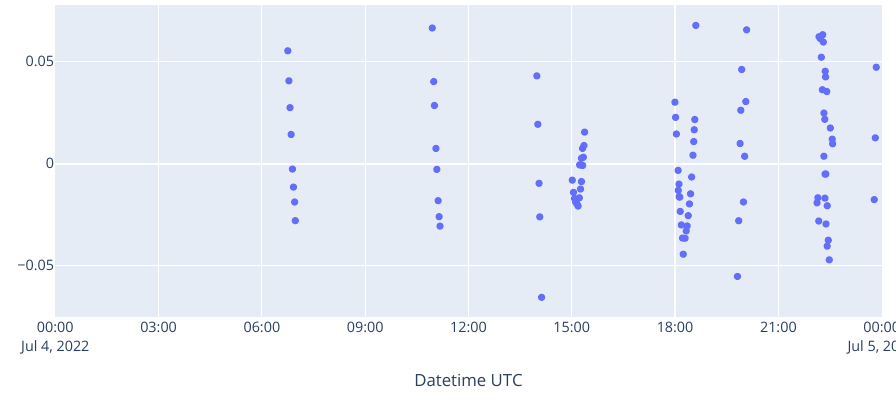
Figure 7. SLR range residuals for the LAGEOS-2